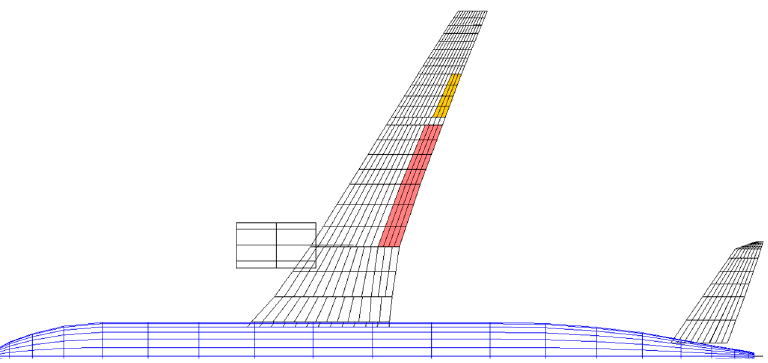
Figure 42. Deflected control surfaces for roll maneuver with the enhanced control surface layout.